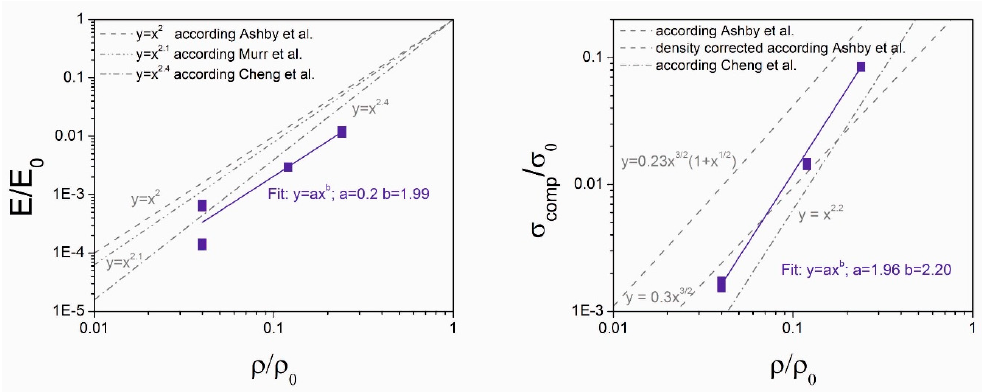
Figure 10. Specific properties of the rhombi-dodecahedron sandwich structure 2 × 2 × 4; the value for E 0 is 210 GPa and for σ 0 200 MPa; fit functions have a 99.9% or higher probability; the grey dotted lines are the values from the literature [17–19].